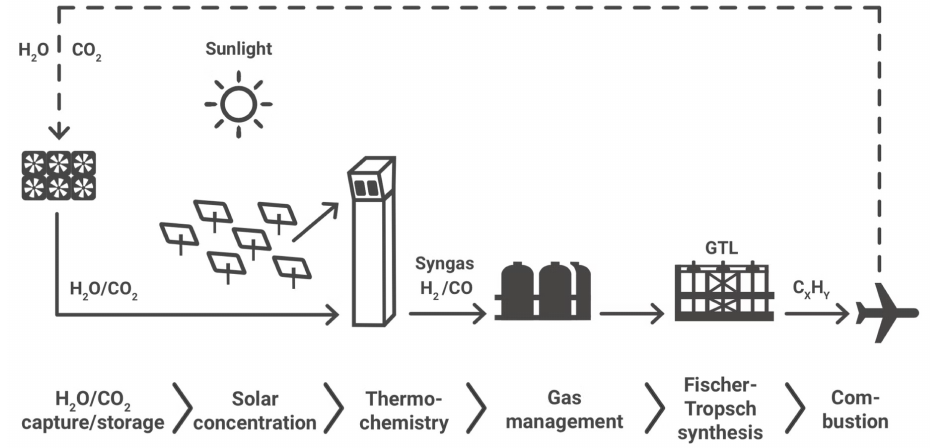
Figure 10. SUN-to-LIQUID fuel production chain [96]. Source: IEA (2018) World Energy Outlook. All rights